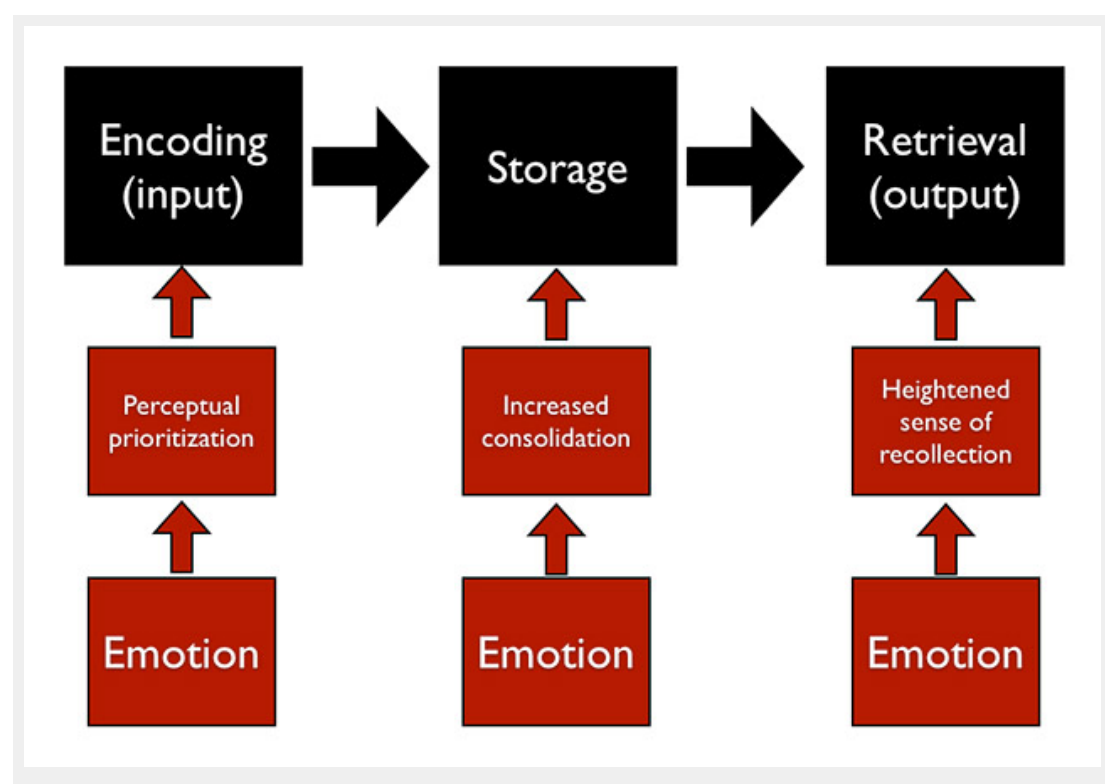
Figure 3 Schematic illustration of the impact of emotion on three different stages of memory processing: (1) By prioritising the perception of emotionally relevant information, encoding of this information may be strengthened. (2) By modulating the consolidation process of emotional information via increases in arousal, emotional information may form more robust memory traces. (3) By enhancing the subjective recollective experience of emotional information, emotional memories may become more central to the planning of current behaviour (see text for more details).